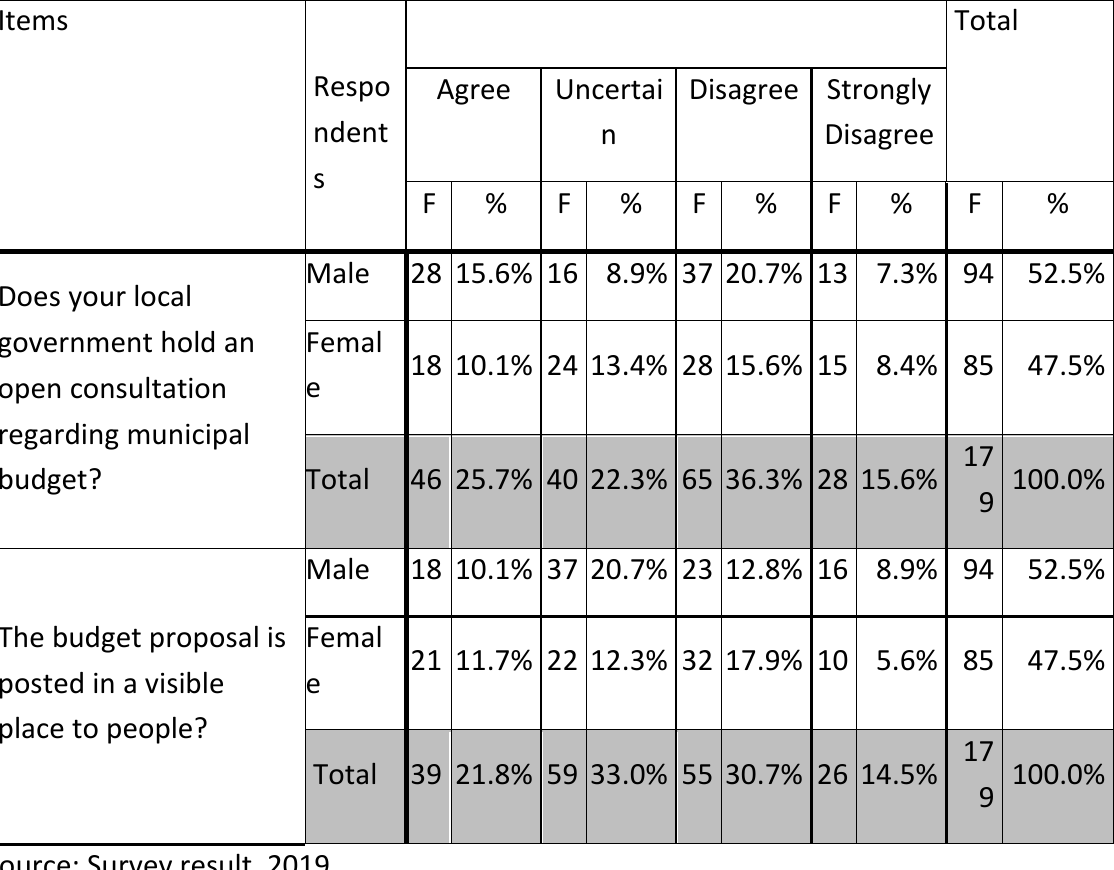
Table 5: Public view regarding municipal budget consultation and publicity of budget